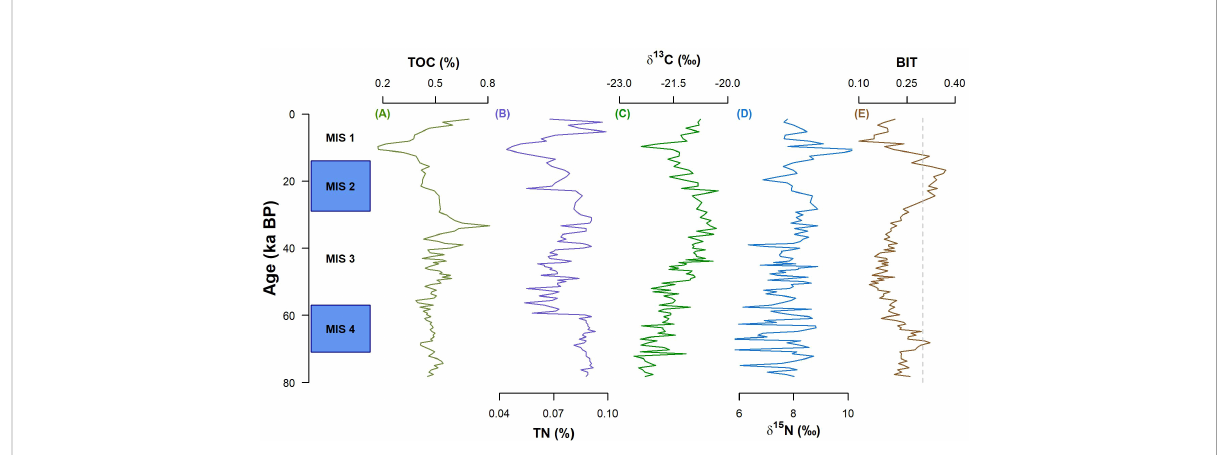
FIGURE 3 Records of the elemental (A, B) and isotopic (C, D) composition, and BIT values (E) for core NAP 63-1. MIS, Marine Isotope